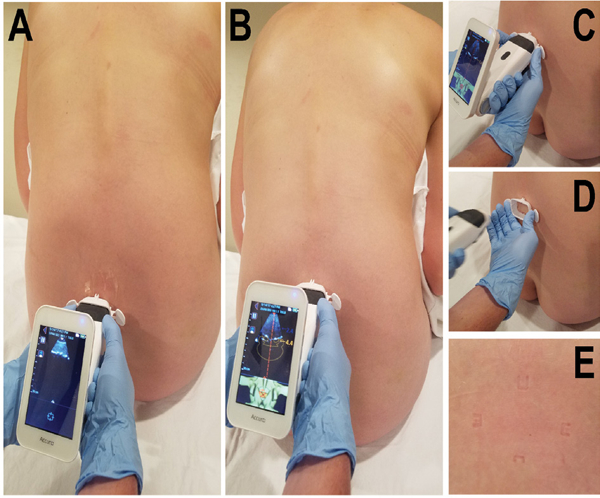
Sequential images of ultrasound imaging protocol used in this study. (A) First, the sacrum was identified as a bright horizontal structure when the device was placed just above the intragluteal cleft. (B) The system was advanced in the cephalad direction while maintaining the midline indicator in the center of the ultrasound viewport. (C) and (D) When the L4- L5 interspace was identified by the system, the skin was marked using the detachable Accuro Locator. (E) Four skin markings left by the Locator. The needle was placed at the center of the 4 indentations, which corresponded to the center of the ultrasound beam that intersected the L4-L5 interspace.